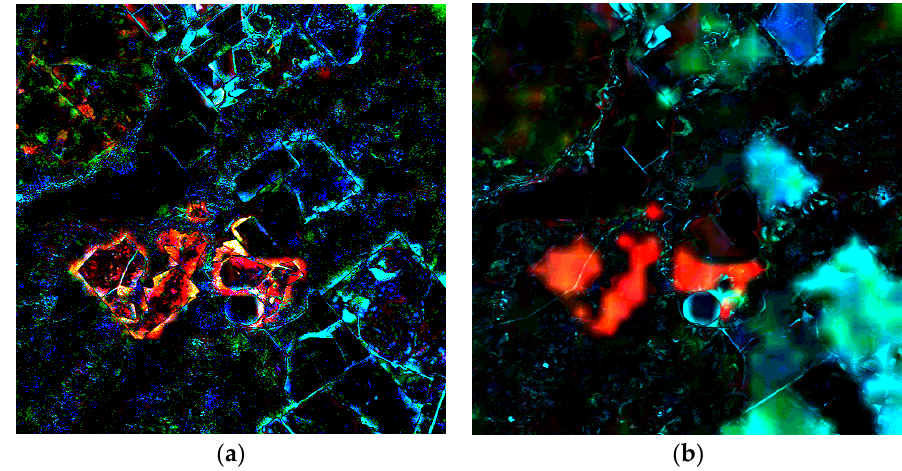
Figure 6. NIR-red-green composites of the squared error (with max values for bands NIR, red and green are 0.0030, 0.0006 and 0.0005) ( a ) and estimation variance (with max values for bands NIR, red and green are 0.0029, 0.0009 and 0.0007); ( b ) results for the first dataset.